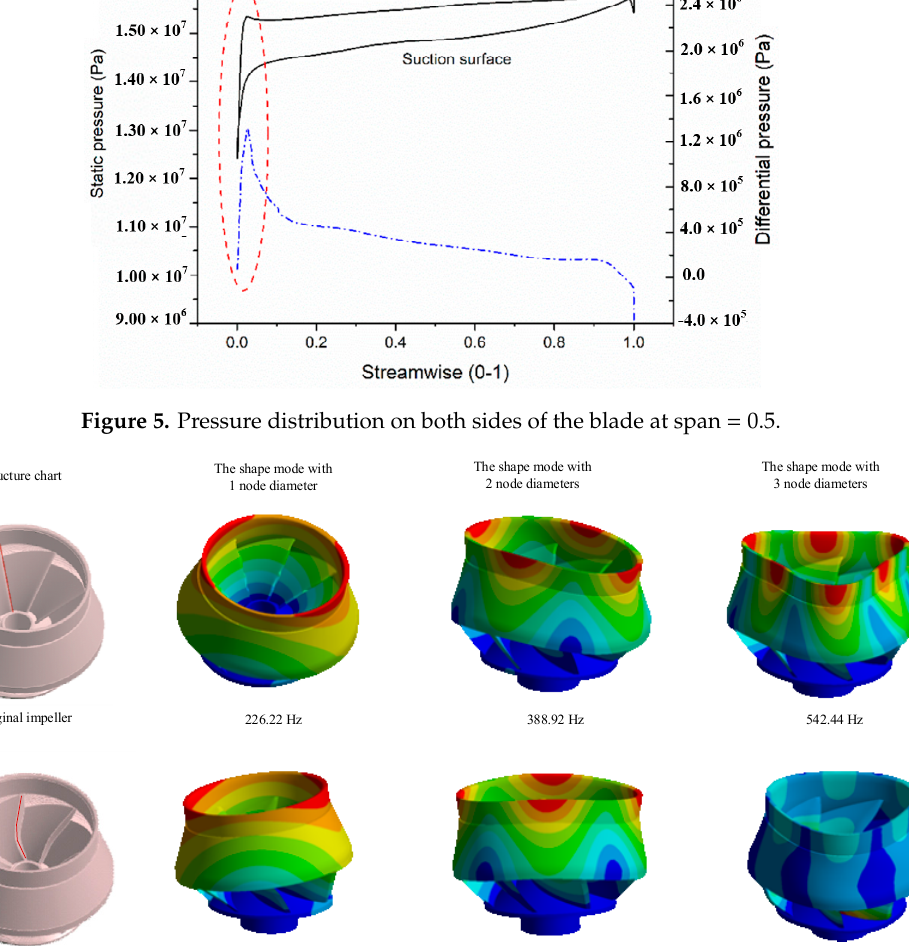
Figure 7. Comparison of stress distribution before and after impeller improvement.